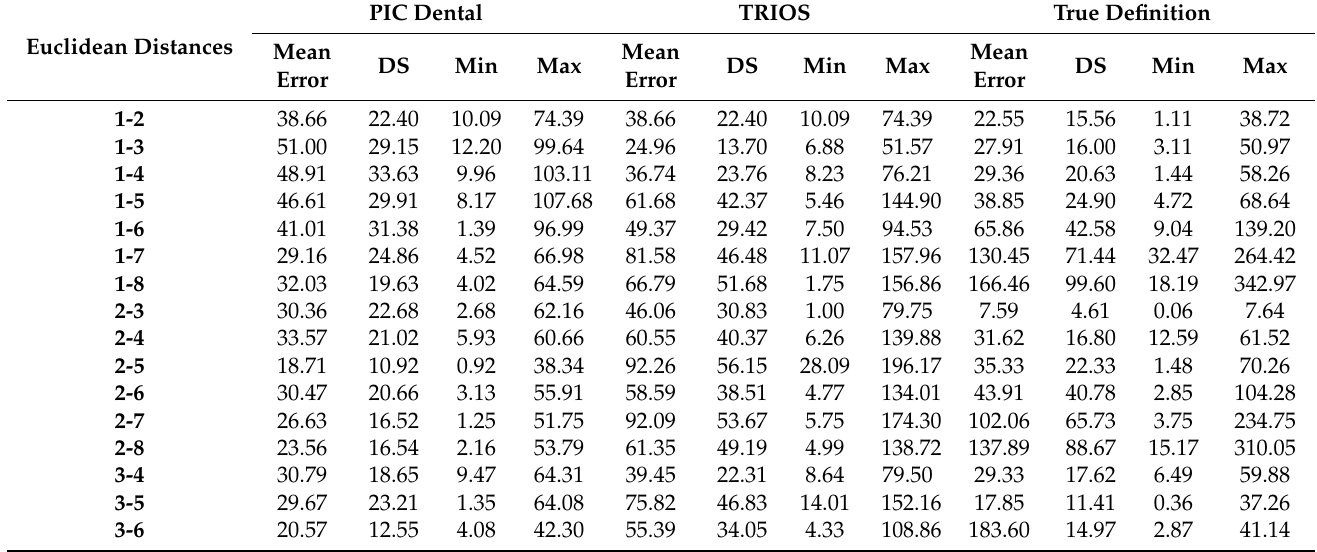
Table 1. Descriptive statistics for each of 28 Euclidean distances ( µ m) of maxillary arch obtained by the three evaluated